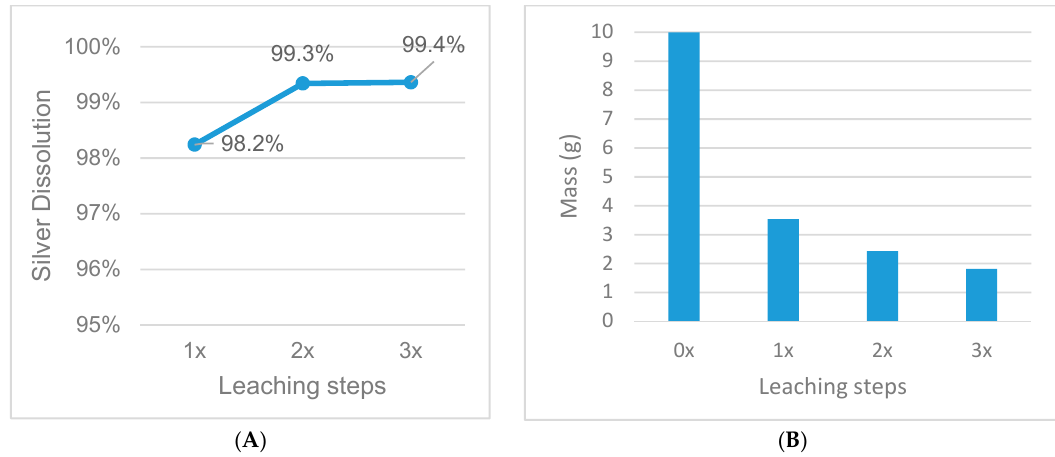
Figure 11. Influence of multiple-step leaching on silver dissolution ( A ) and mass reduction ( B ), fixed parameters: 30% HNO 3 , s/l = 1/20, 1 h leaching duration, 65 °C.